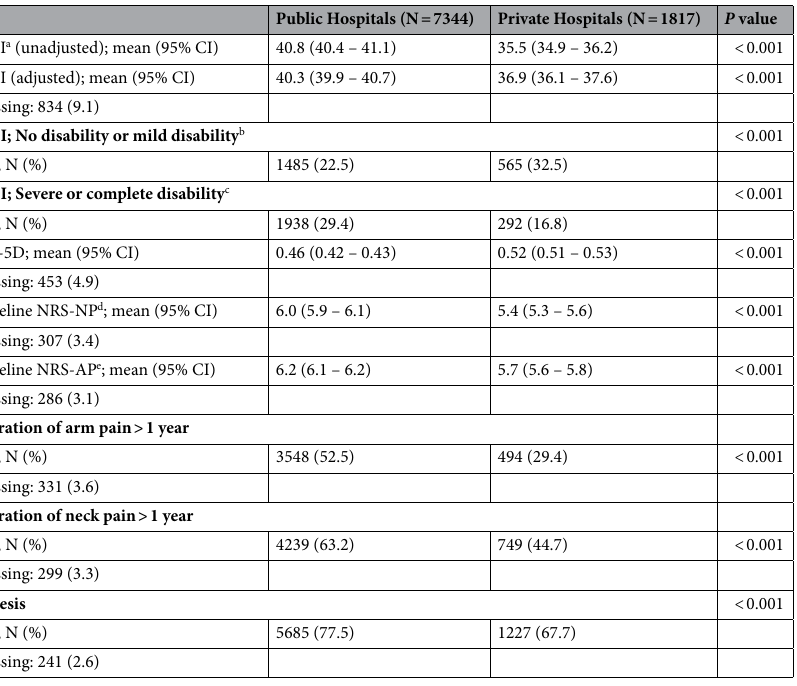
Table 2. Pre-operative PROM scores of patients operated for cervical degenerative disorders in public and private hospitals. a Neck disability index. b Mild disability = 10 – 29. c Severe disability = 50 – 69. d Numeric rating scales for neck pain. e Numeric rating scales for arm